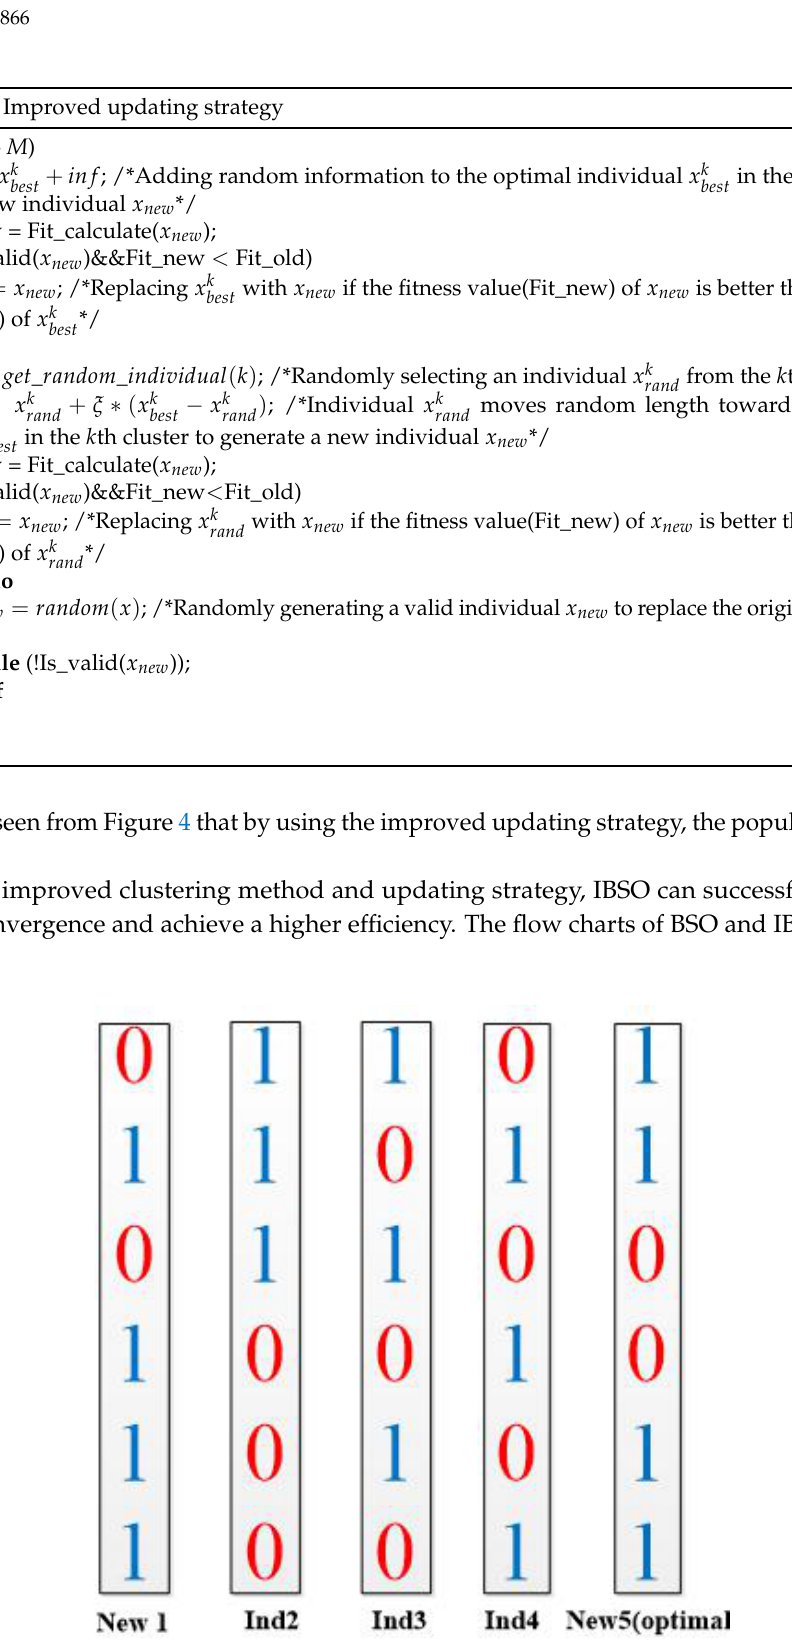
Figure 4. Individuals updated by the new